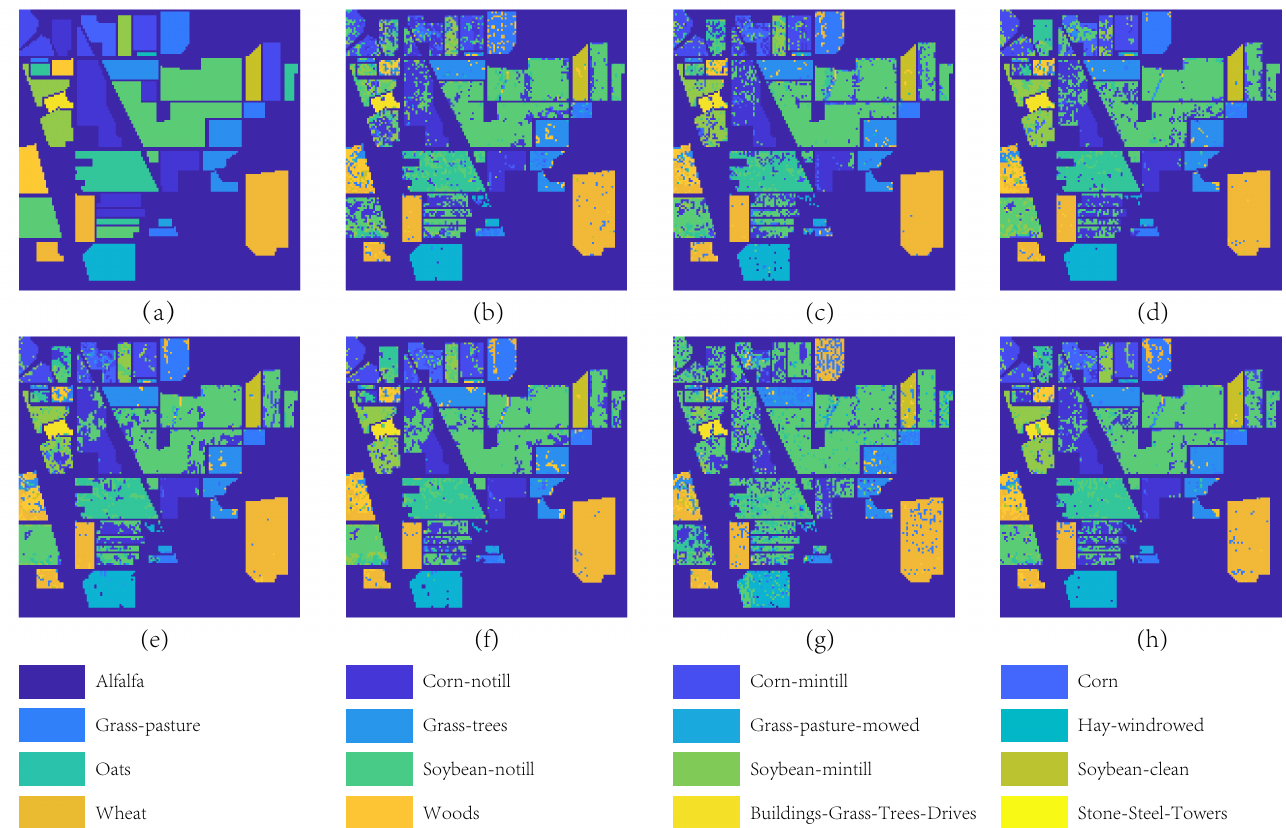
Figure 5. The visualization of classification on the Indian Pines dataset. ( a ) Ground truth; ( b ) PCAS; ( c ) PCA; ( d ) ONR; ( e ) NC-OC-MVPA; ( f ) NC-OC-IE; ( g ) LvaHAI; ( h ) BAMGC.